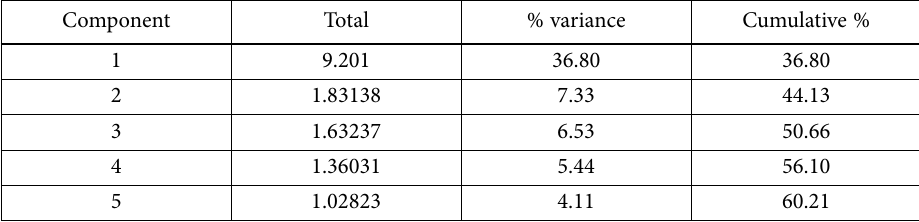
Table 1. Initial eigenvalues (source: own, 2018) Component